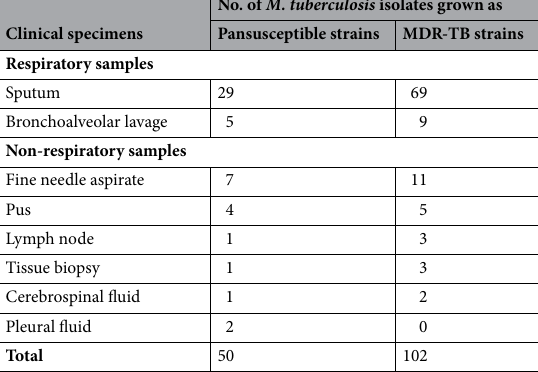
Table 1. Clinical source of pansusceptible M. tuberculosis and MDR-TB